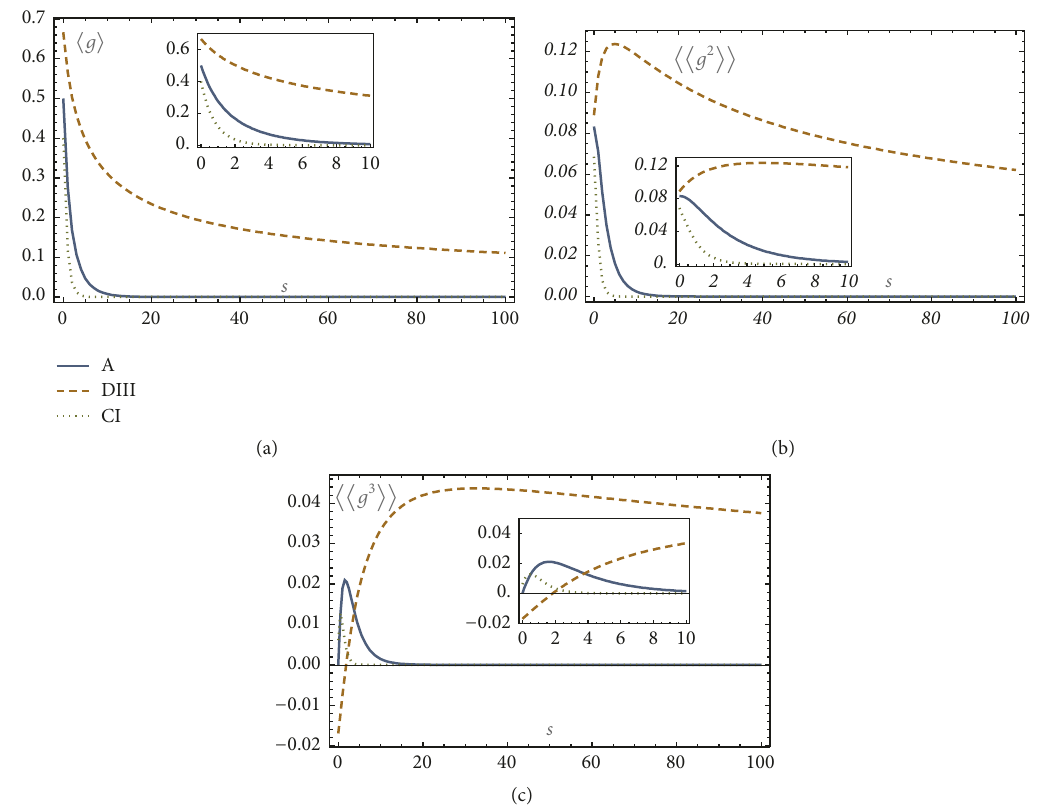
Figure 2: The first three cumulants of the thermal conductance for the WD (full line) and BdG classes DIII (dashed line) and CI (dotted line) with a single open channel: 𝑁 1 = 𝑁 2 = 1 . The insets show the small 𝑠 behaviors. Note the qualitative difference of the class DIII BdG